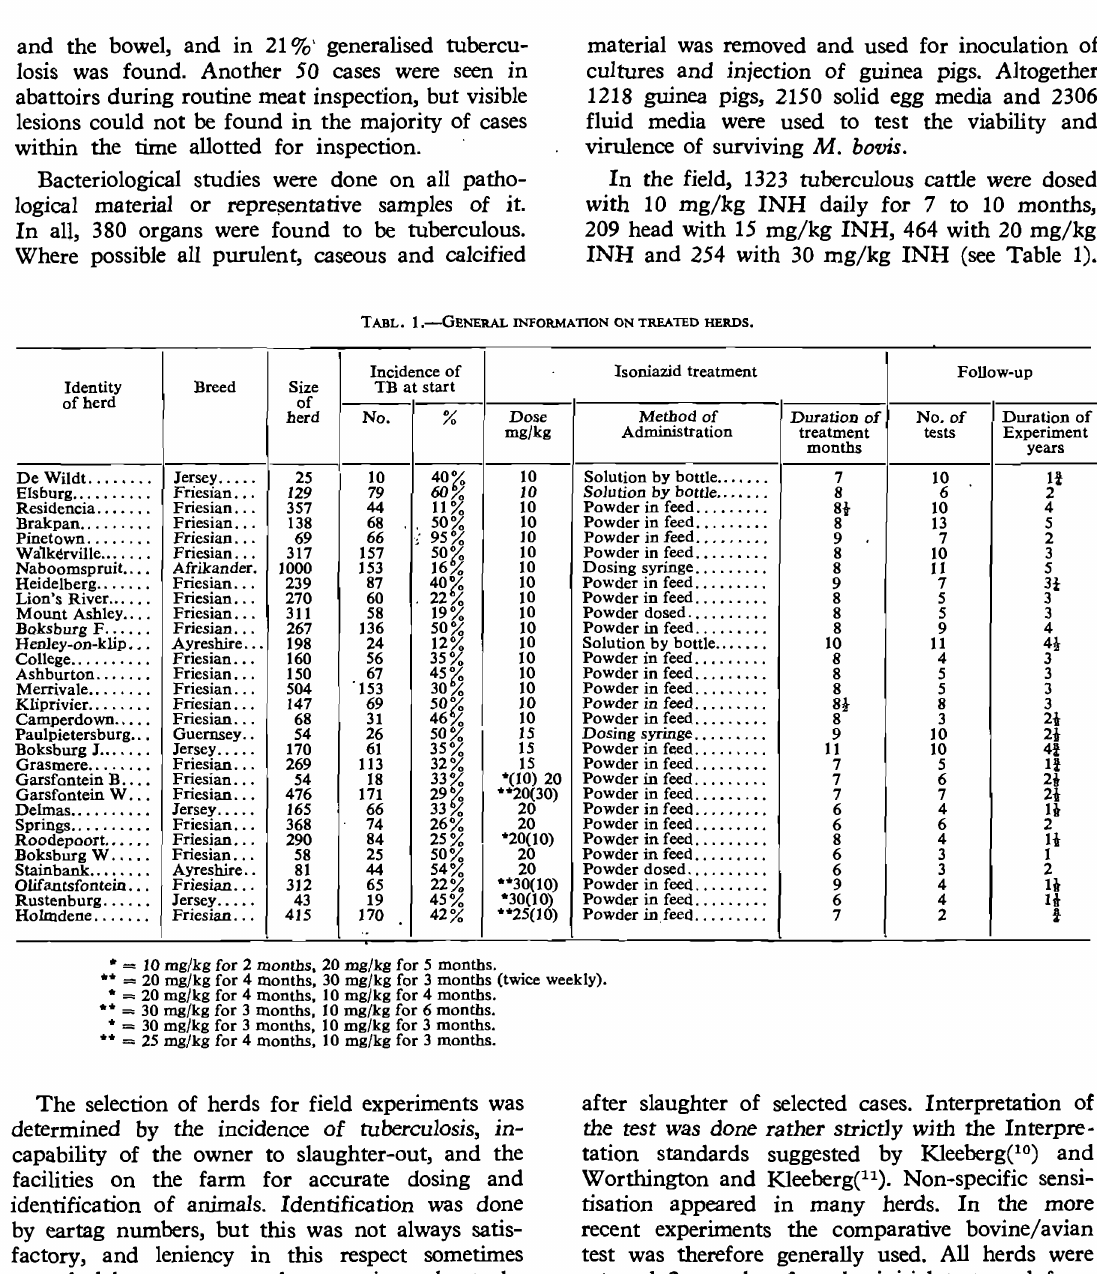
TABL. I.-GENERAL INFORMATION ON TREATED